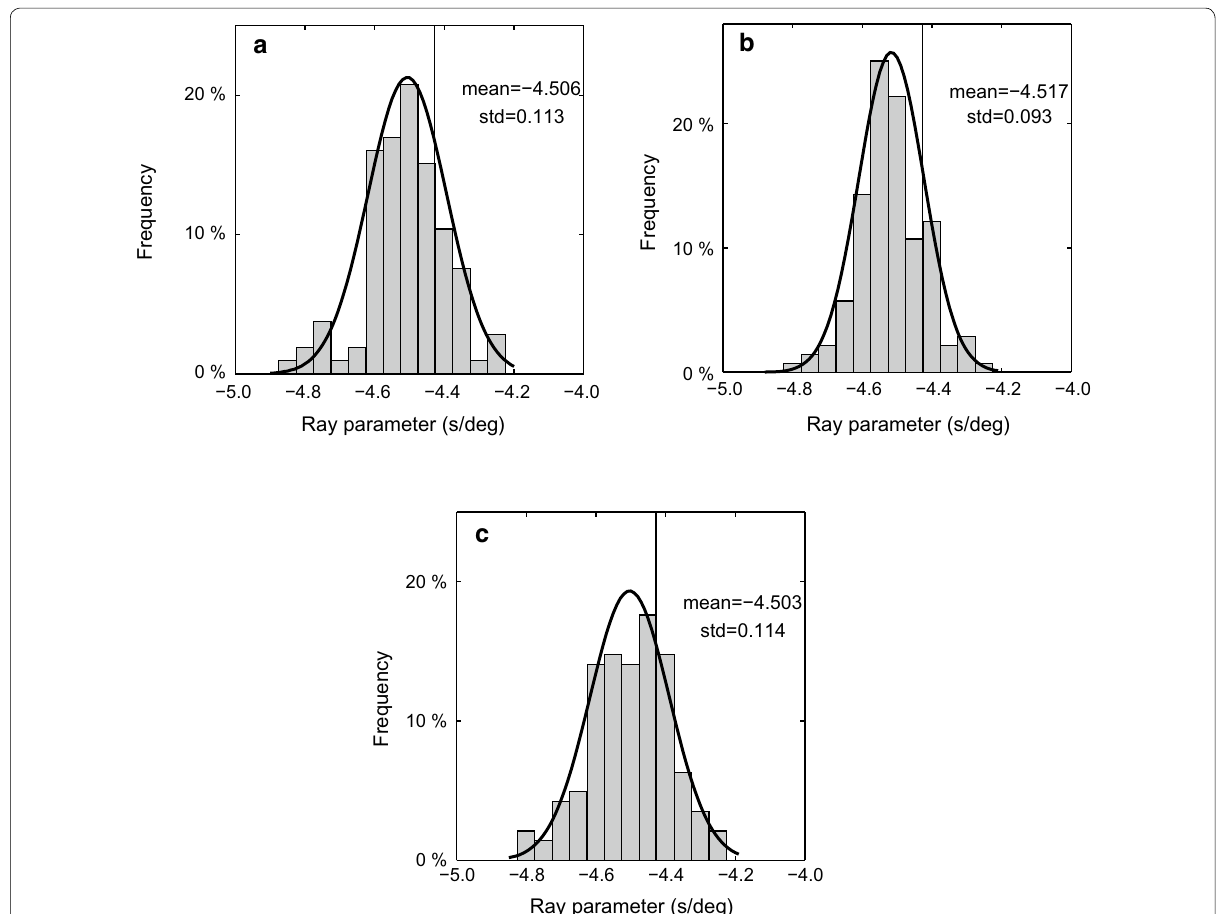
Fig. 6 a Histogram of PKKP ab diffraction ray parameters after ellipticity and mantle heterogeneity corrections. The seismograms are band-pass filtered between 0.9 and 2.1 Hz. The mean value of the ray parameters is 4.506 s/deg, and the standard deviation is 0.113 s/deg. The vertical black line denotes the theoretical ray parameter of PKKP ab diffraction calculated for PREM. b , c same as a , but for the ray parameter distribution of PKKP ab diffractions from 0.5–1.5 Hz and 0.5–2.1 Hz bands,